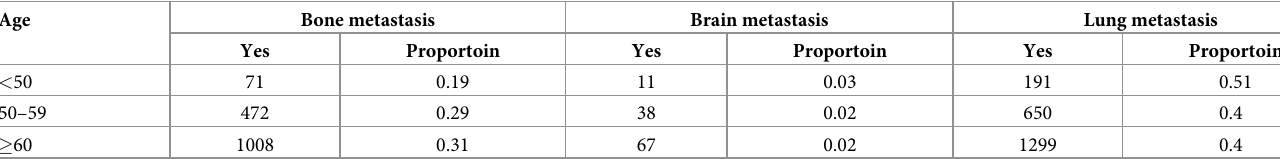
Table 2. The proportion of metastases patterns in different age